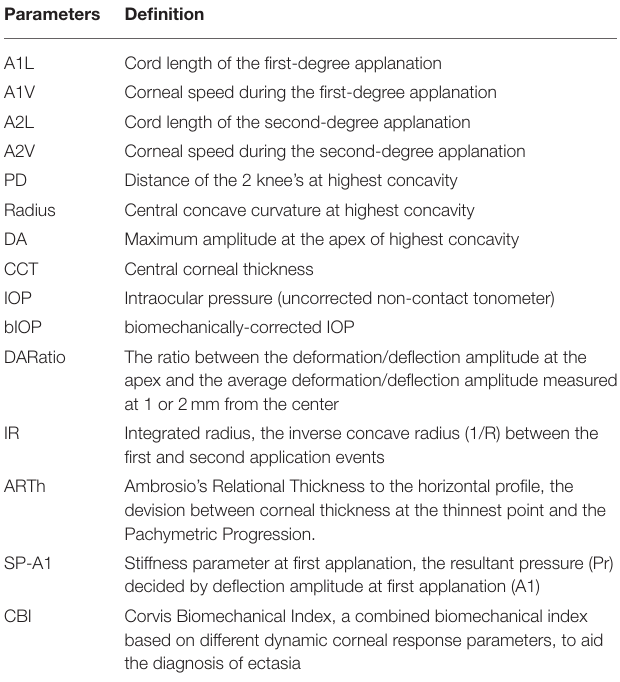
TABLE 1 | Corneal biomechanical parameters of Corvis